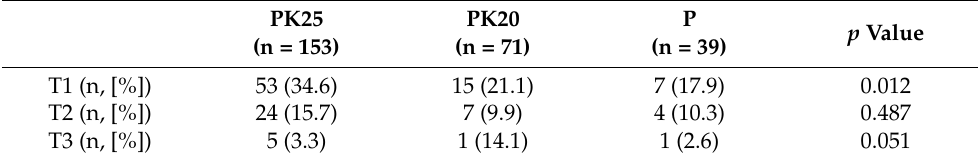
Table 3. Incidence rates of adverse events according to sedative type.